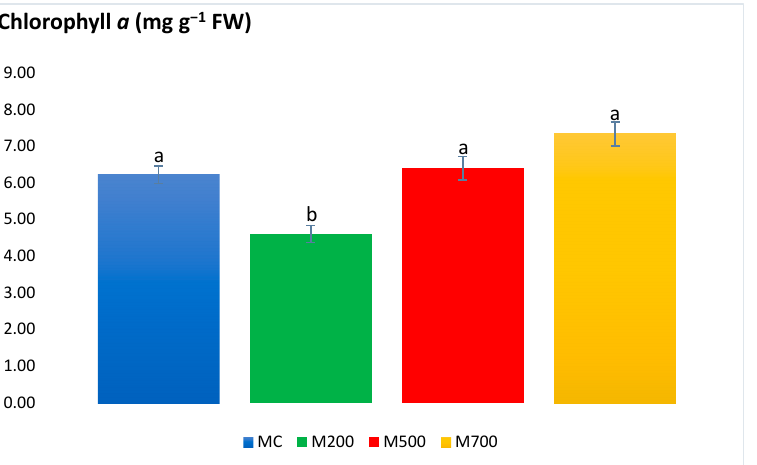
Figure 3. Concentration of chlorophyll a in the leaves of Mis-B cultivar cultivated in soils with gradient T.E. concentrations (MC, M200, M500, M700). Values are presented as mean ± SE. Different letters refer to significant differences between plants (Tukey HSD test, n = 6, p ≤ 0.05).